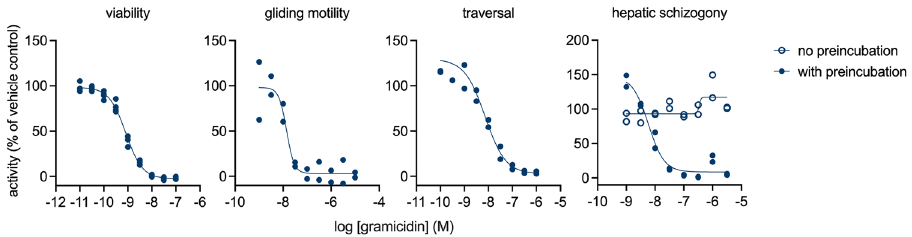
Fig. 6 Sporontocidal activity of gramicidin. The fi gure shows dose-response analyses of gramicidin in sporozoite viability, gliding, traversal, and hepatic schizogony assays. In the latter assay, sporozoites were pre-incubated with gramicidin for 30 min prior to hepatocyte infection, or directly added to the host cells. The fi gures show data normalized to the respective positive and negative controls in the assays. Each condition was tested in 2 –